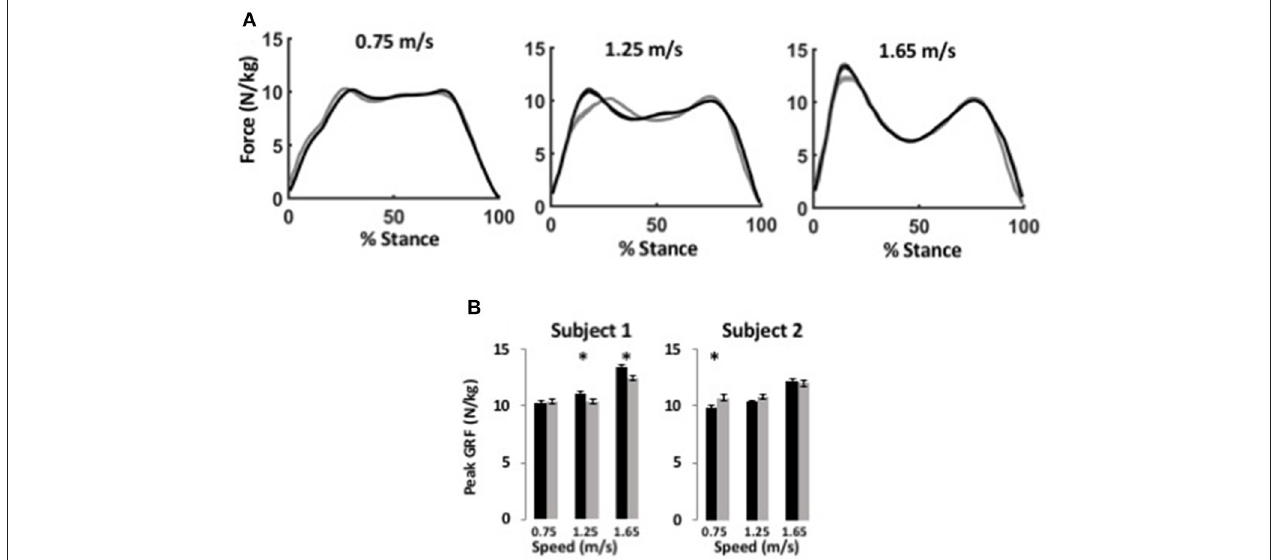
FIGURE 3 | WFH (gray) and BiOM stock (black) controllers produce similar ground reaction forces during level walking at variable speed. (A) Average ground reaction force (N/kg) ± SEM vs. % stance for Subject 1 at three speeds. Left, 0.75 m/s; center, 1.25 m/s; right, 1.65 m/s. (B) Average peak ground reaction force (N/kg) ± SEM for two subjects. Asterisks (*) represent statistical differences ( P < 0.05) using Steel-Dwass non-parametric comparisons of median values.